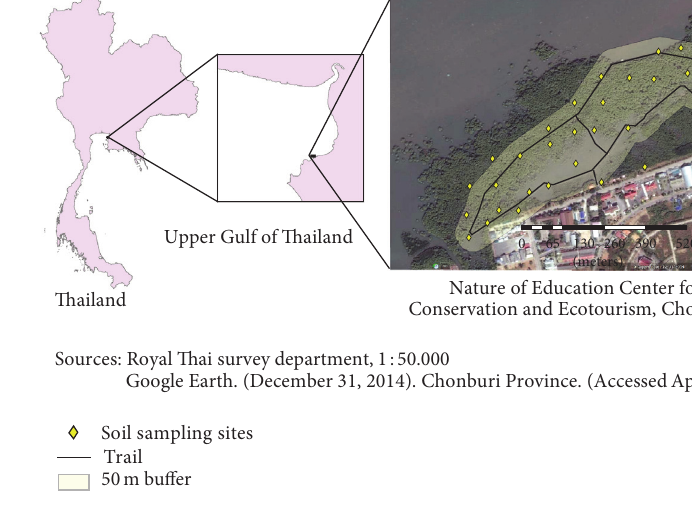
(FreeZone6, Labconco, USA) and then ground to a